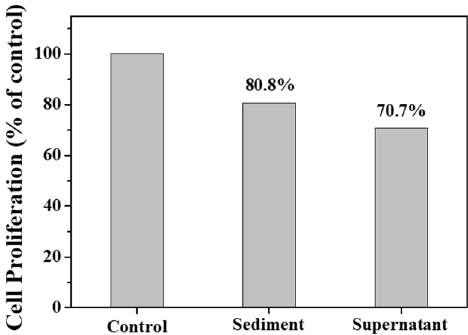
Figure 10. MCF-7 cells cultured with ( a ) sediment (50 µ L) and ( b ) supernatant (50 µ L) after 1, 4, 12 and 24 h.